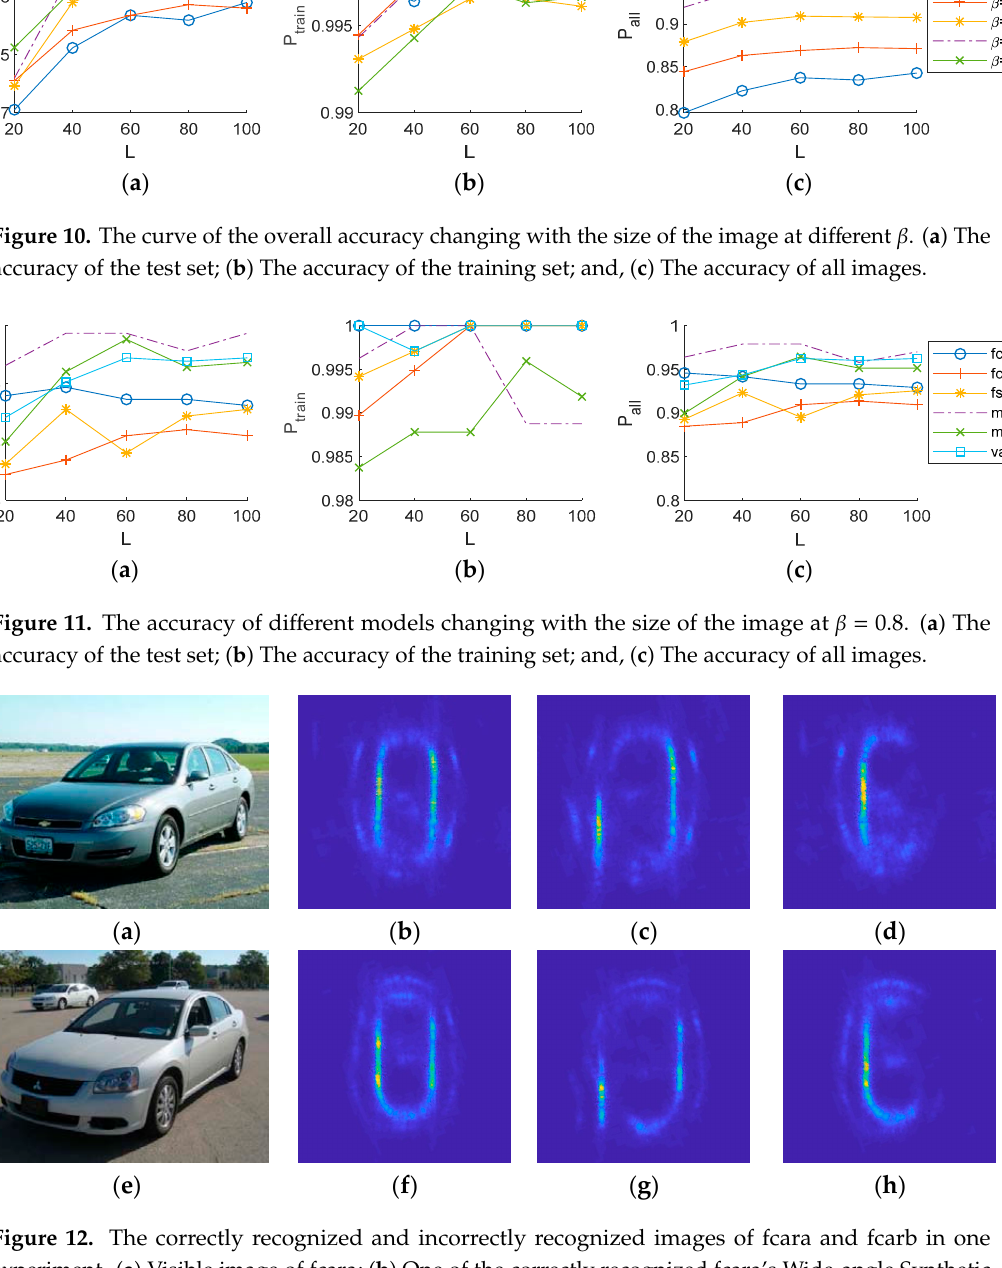
Figure 12. The correctly recognized and incorrectly recognized images of fcara and fcarb in one experiment. ( a ) Visible image of fcara; ( b ) One of the correctly recognized fcara’s Wide-angle Synthetic Aperture Radar (WSAR) images; ( c , d ) One of the incorrectly recognized fcara’s WSAR images. ( e ) Visible image of fcarb; ( f ) One of the correctly recognized fcarb’s WSAR images; and, ( g , h ) One of the incorrectly recognized fcarb’s WSAR images.